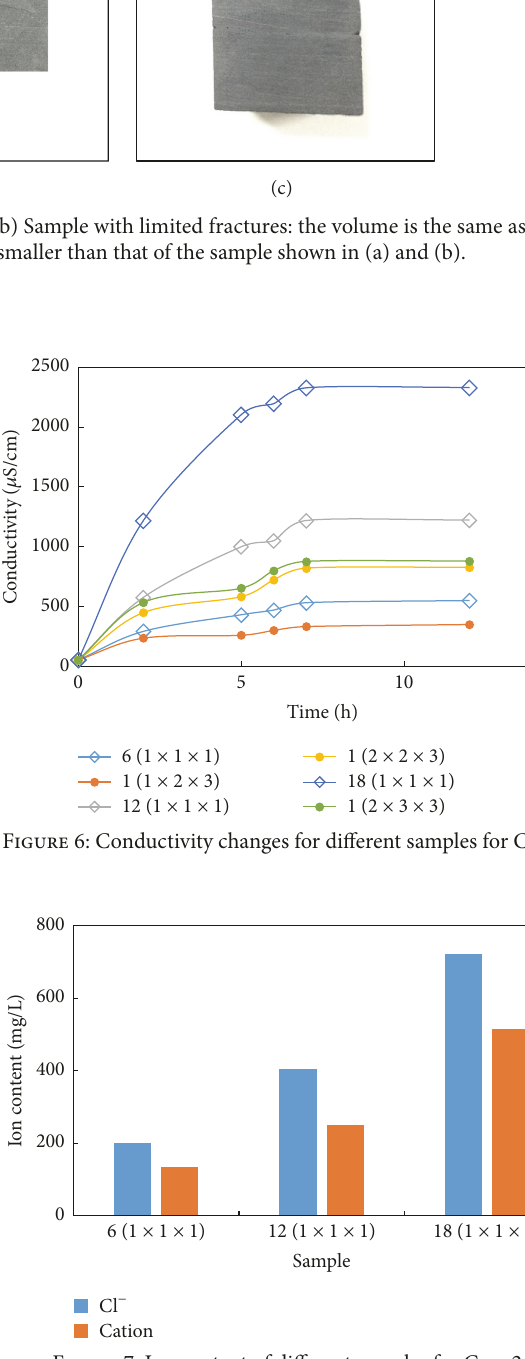
Figure 7: Ion content of different samples for Case